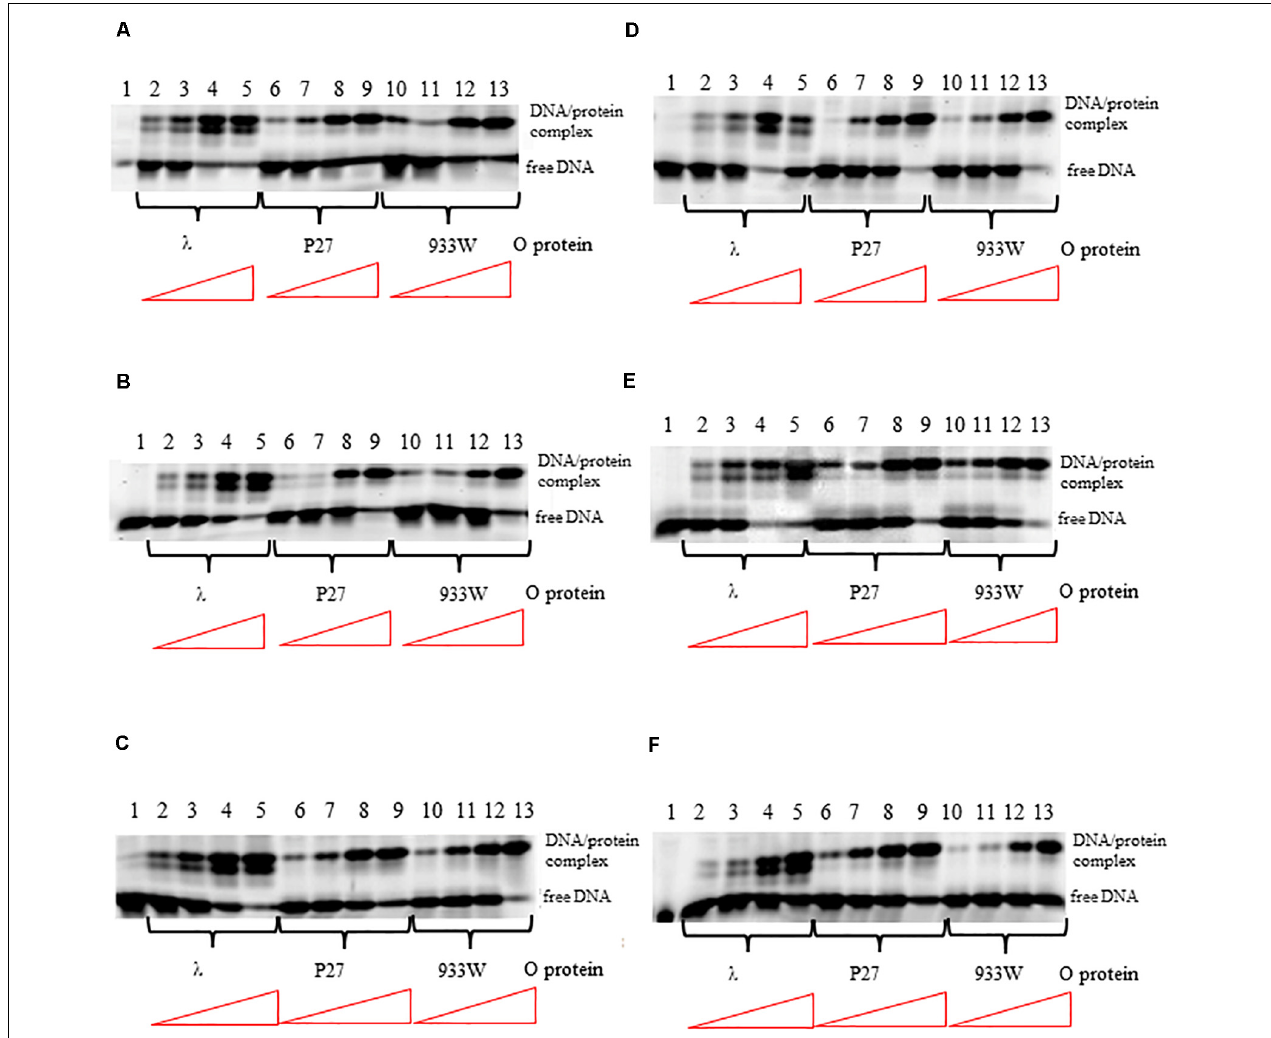
FIGURE 3 | Interactions of O proteins of phages λ , P27 and 933W with DNA templates containing single iterons: iteron 1/1 (cid:48)(cid:48) (A) , iteron 1 (cid:48) (B) , iteron 2 (C) , iteron 3 (D) , iteron 3* (E) , and iteron 4 (F) . Increasing molar ratios of DNA:O proteins, indicated in particular wells, were as follows: 1:1, 1:2, 1:4, and 1:8. Lane no. 1 contains no O protein. Note that lanes 10/11 in panel A, and lanes 4/5 in panel D, are swapped.